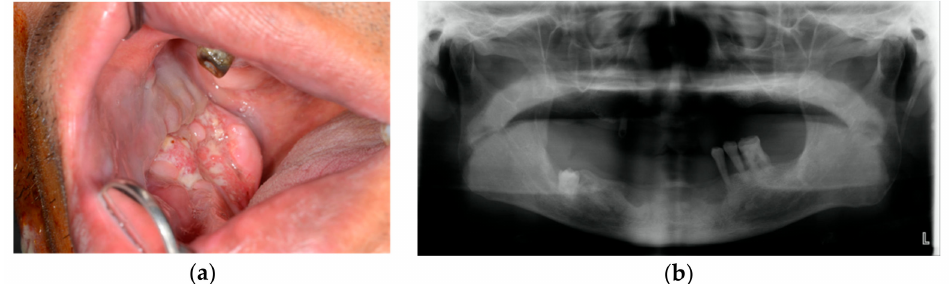
Figure 1. Initial examinations: ( a ) Intraoral photograph showing the granulomatous lesion on the right lower gingiva; ( b ) Panoramic view showing the impacted tooth and osteolytid lesion. Incisional biopsy results were diagnosed as SCC, and CT and PET-CT images were taken. Osteolytic lesions of the mandible and lymph nodes on the right at level I with intense fluorodeoxyglucose (FDG) uptake were observed on the radiological images. Therefore, segmental mandibulectomy and selective neck dissection (I–V) were planned for the management of the SCC, and use of the DCIA-based iliac crest flap was planned to reconstruct the resected mandibular